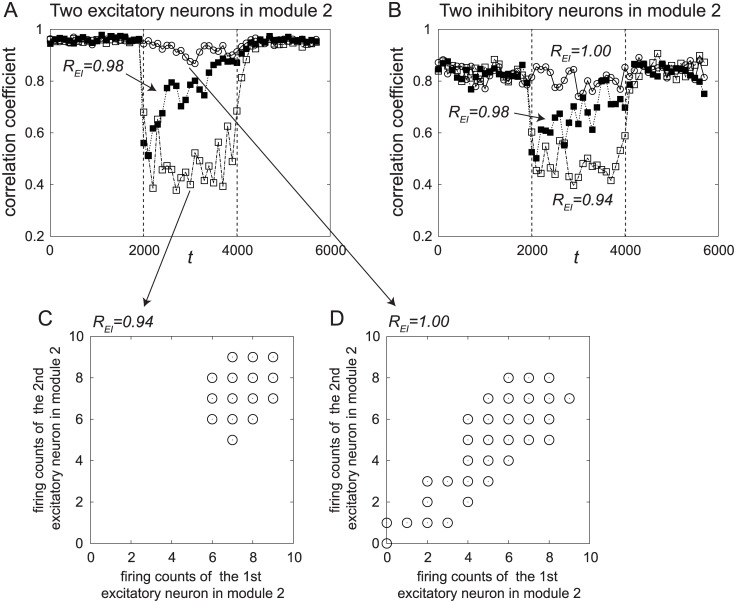
The correlation coefficients between the firing counts of pairs of neurons.(A, B) Temporal changes in the correlation coefficients of firing counts in the excitatory ensemble and the inhibitory ensemble in the second module. Two neurons were randomly chosen from each ensemble, and the correlation coefficient was calculated from data for 100 trials. (C, D) Distribution of the firing counts of two neurons, for (C) REI = 0.94 and (D) REI = 1.